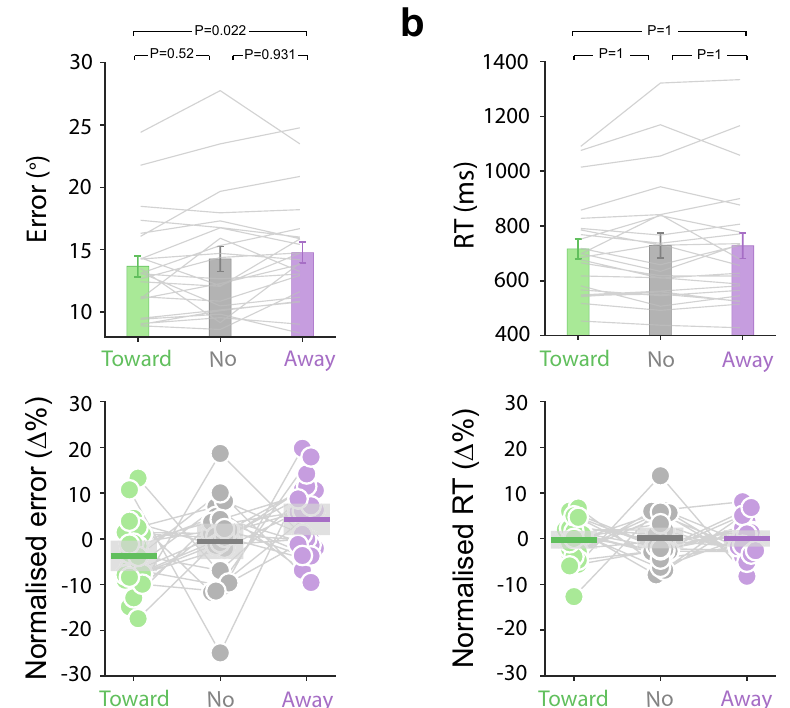
Fig. 2 Behavioural performance as a function of microsaccade direction and presence. a Mean reproduction errors (the absolute deviation between the target orientation and the reported orientation in degrees) and b mean reaction times (the time between cue onset and report onset) in trials in which the fi rst-detected microsaccade in the de fi ned 200 – 600 ms selection period was toward (green) or away (purple) from the memorised location of the cued memory item, or in which no microsaccade was detected (grey). Top panels show raw performance with grey lines indicating individual-participant data, while the bottom panels show normalised performance (percent change from mean) together with individual data points. Error bars in the top panels indicate ±1SEM. Shadings in the bottom panels indicate 95% con fi dence interval. Both the SEM and con fi dence interval are calculated across participants ( n = 23). The statistical tests used in the fi gure were two-sided paired samples t -test. The reported P values are all Bonferroni corrected. Source data are provided as a Source Data fi